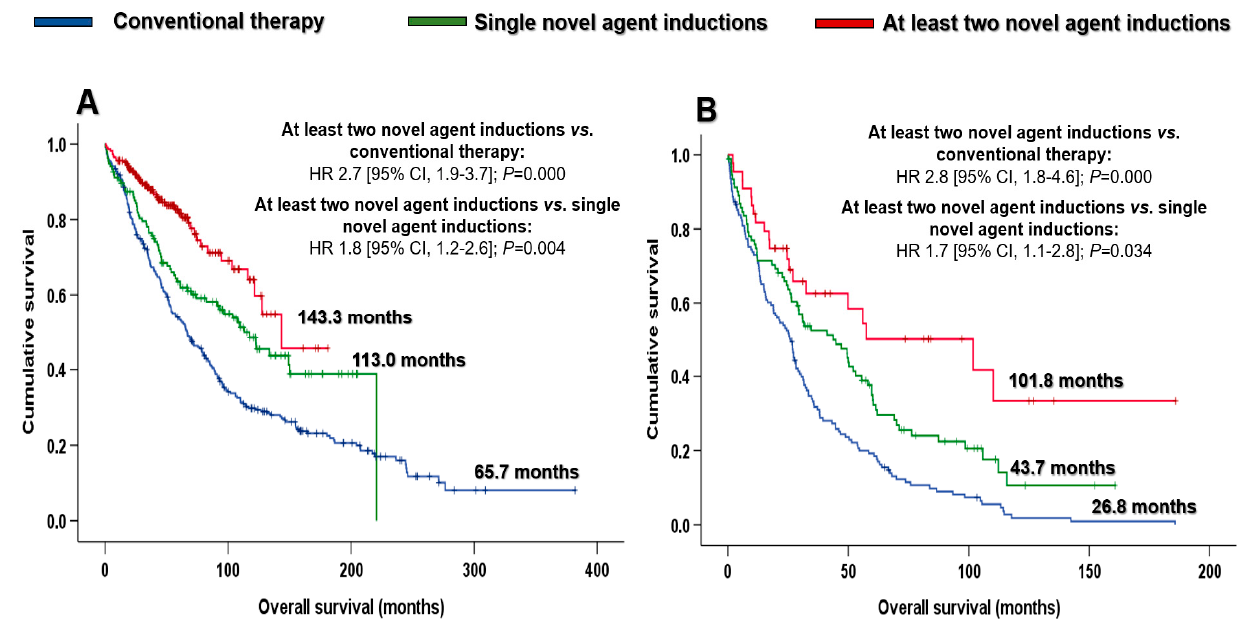
Figure 4. Overall survival by induction therapy and age at diagnosis: ( A ) ≤ 70 years and ( B ) >70 years. Abbreviations: CI: confidence interval; HR: hazard ratio. Abbreviations: CI: confidence interval; HR: hazard